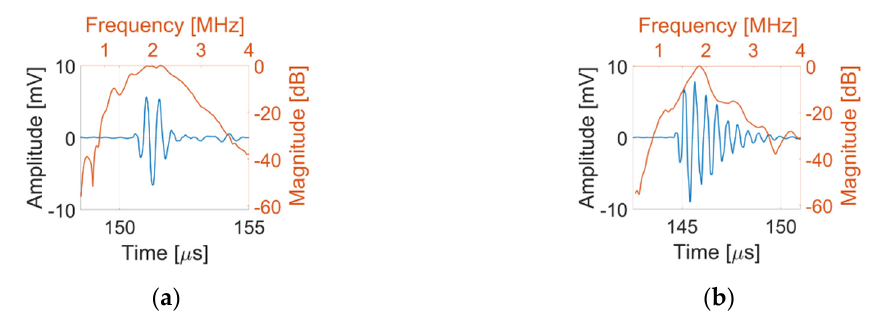
Figure 9. Pulse-echo response of the centre element for ( a ) the CECAT and ( b ) the C1–3. Table 4. Pulse-echo response results for both prototype transducers.